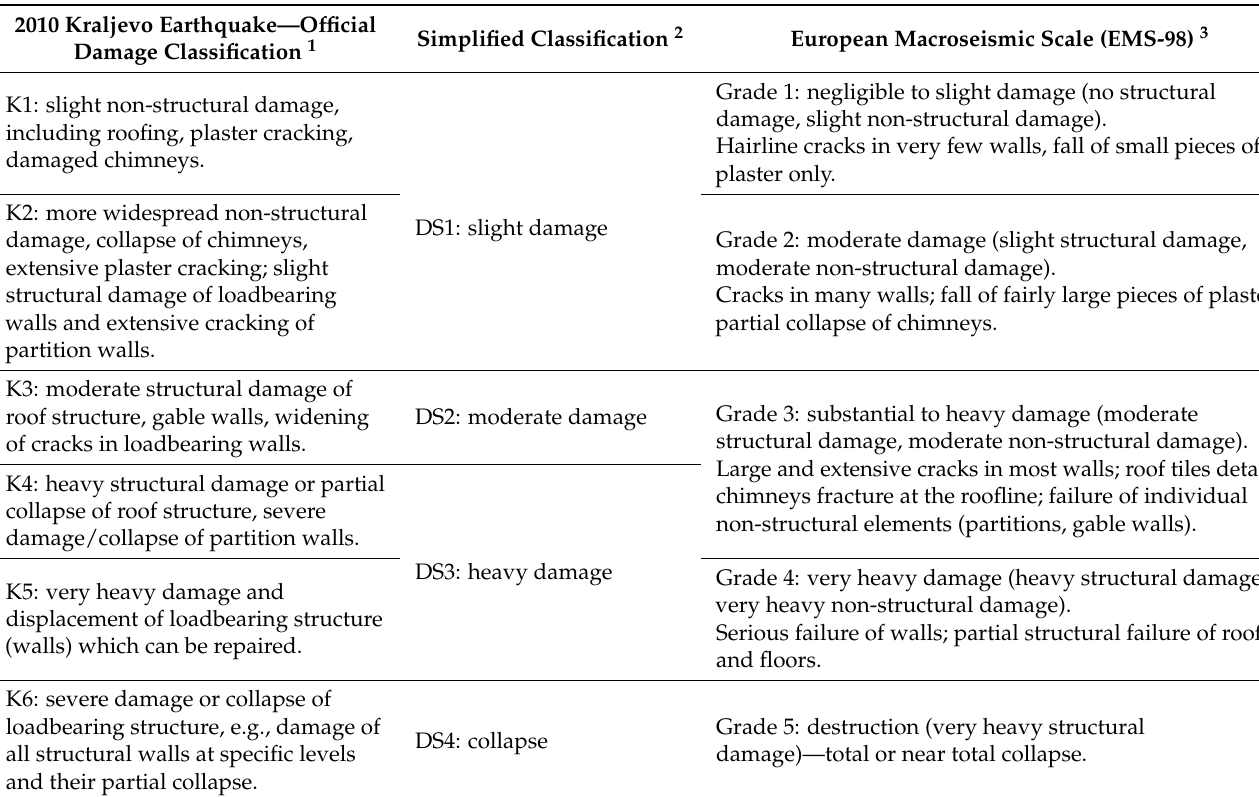
Table 5. Damage classification for masonry buildings affected by the 2010 Kraljevo